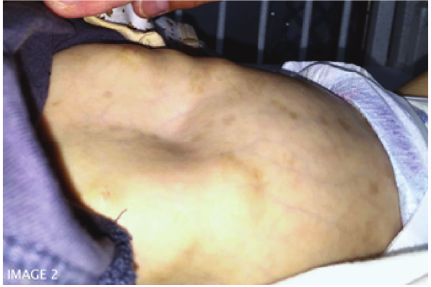
Figure 2: An image of the patient demonstrating pectus excavatum.